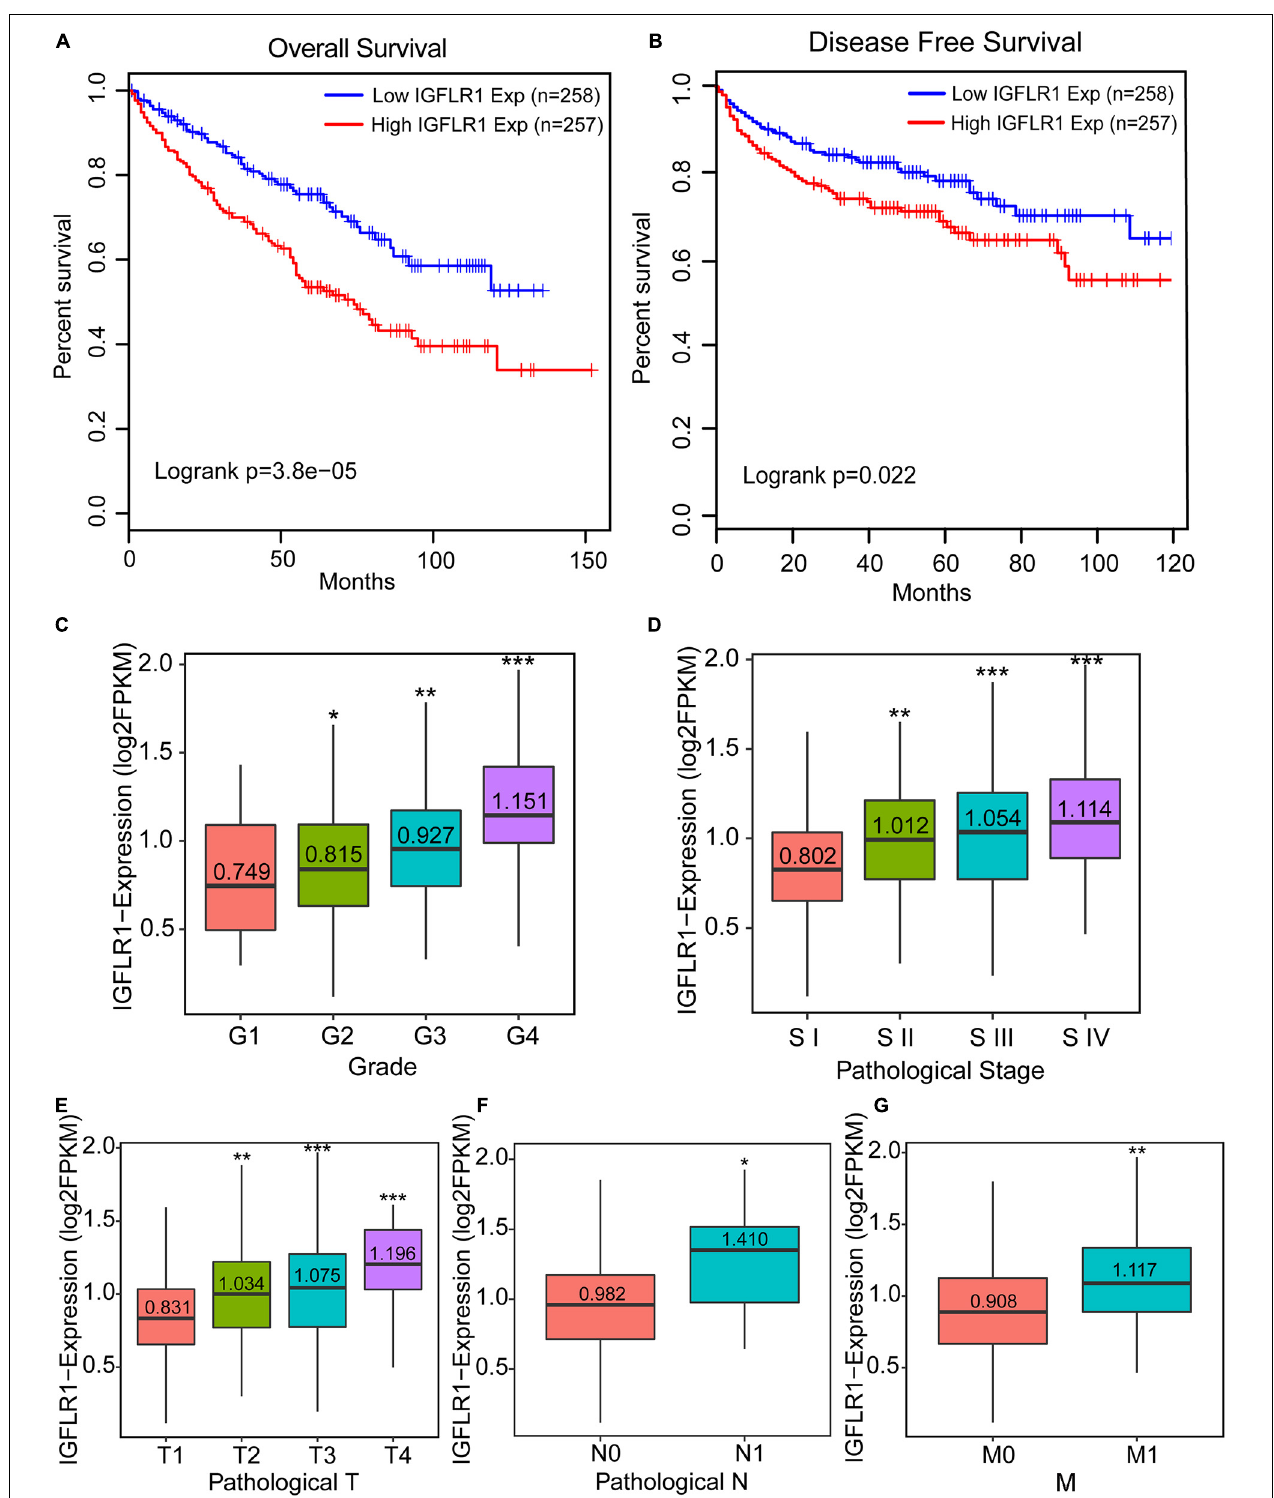
FIGURE 3 | Prognostic potential of IGFLR1 in ccRCC. (A,B) Survival curves of OS and DFS in ccRCC ( n = 515). We used log-rank test to analyze IGFLR1 expression in ccRCC with 50% as cutoff value to generate survival curves including OS and DFS. (C–G) Boxplots show the distribution of IGFLR1 expression level of ccRCC tumor samples stratified by pathologic stage, T, N, M and histological grade. All the advanced tumors were compared with stage1, Grade1, N0, T1, and M0 tumors. OS: overall survival; DFS: disease free survival. (Median of expression level were compared using independent group t tests when the data were normally distributed; otherwise, the Wilcoxon test was used (n.s.: not significant, * p < 0.05, ** p < 0.01, *** p < 0.001).